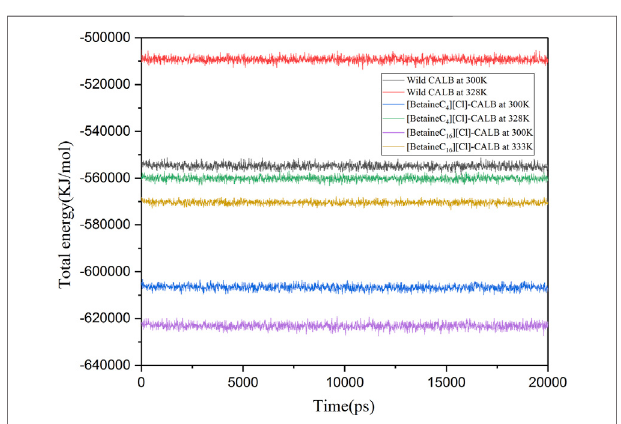
FIGURE 8 | Changes in the total energy of native and modi fi ed enzymes at their respective optimal temperatures.